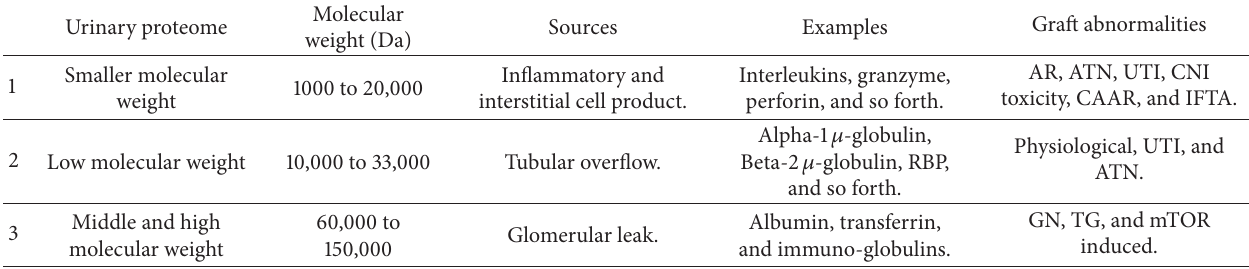
Table 1: Classification of urinary proteomes based on their molecular weight characteristics. Urinary